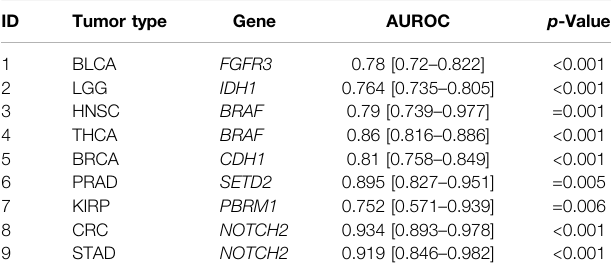
TABLE 1| Topgenesresultoverview. Singlegeneanalysisresultswithareaunder the receiver operating curve (AUROC), con fi dence interval and p -Value. Selected genes were very well predicted by the neural network with AUROCs at least above 0.75. (1 – 3) FGFR3, PBRM1, IDH1 are clinically relevant, (4 – 6) CDH1, BRAF is associated with different morphological features and (7 – 9) SETD2, NOTCH2 have prognostic value.